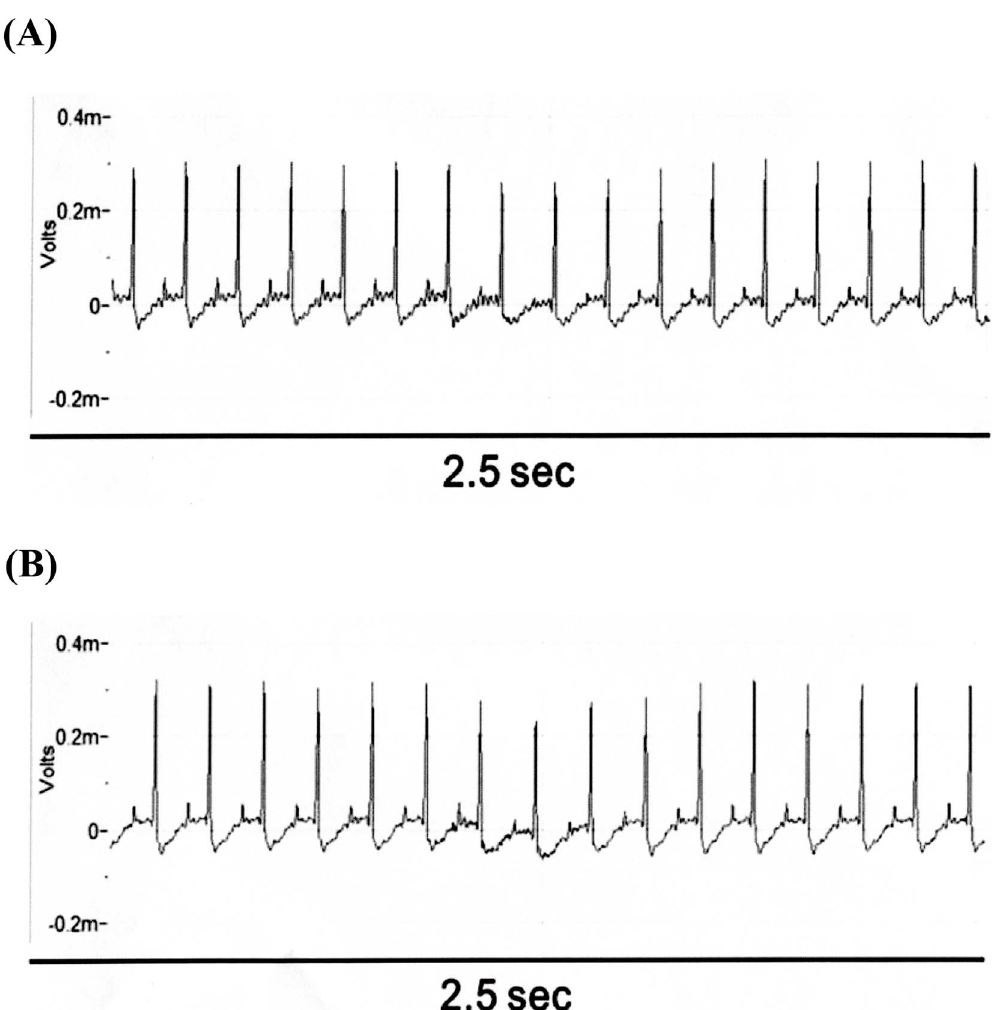
Figure 5. Effect of GW0742 on Electrocardiographic Pattern and Changes. There was no difference between the vehicle treated group (A) and the GW0742 treated group (B).